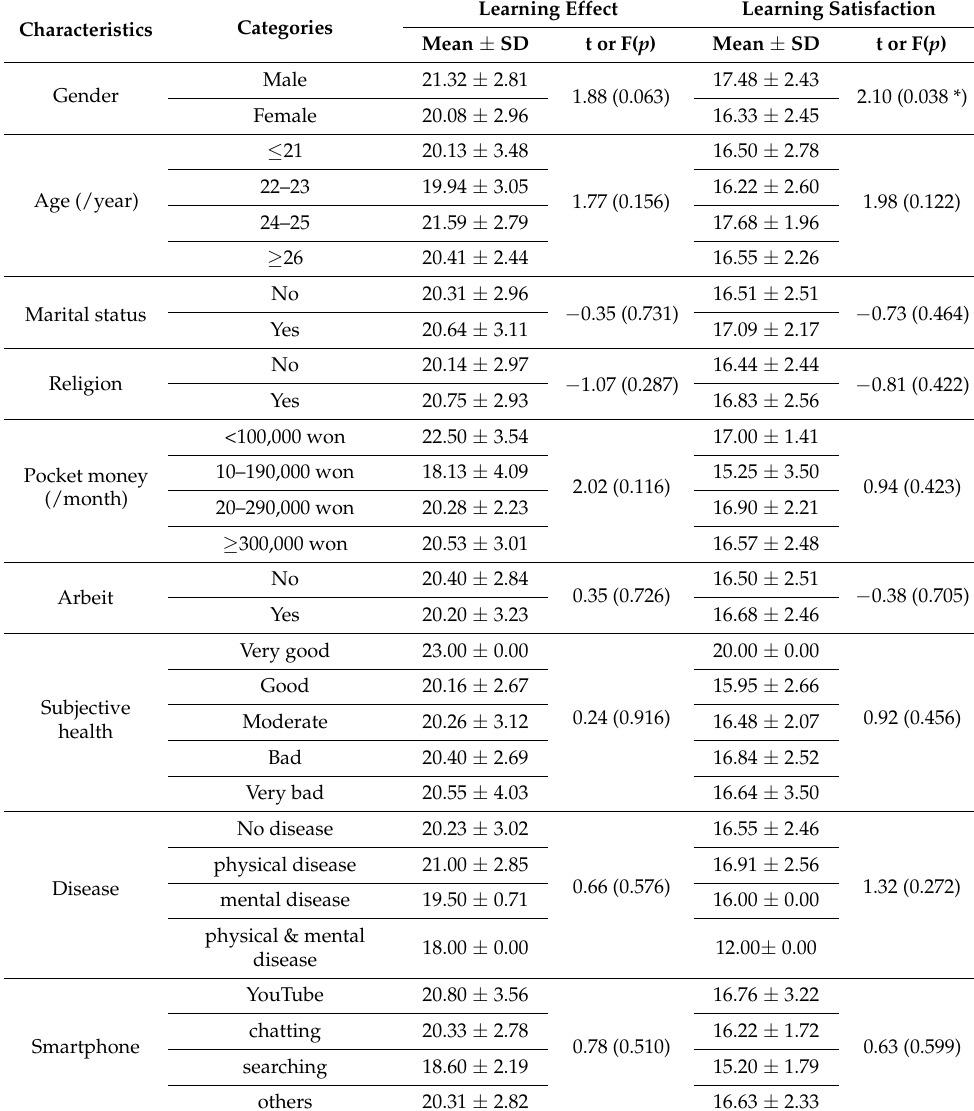
Table 3. Differences in learning effect and learning satisfaction according to the general characteristics of